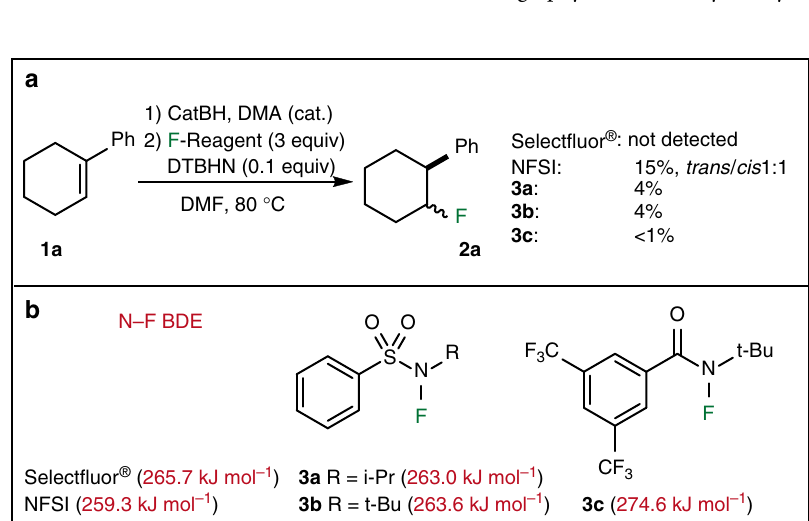
Fig. 2 Initial attempts of hydro fl uorination via formation of B -alkylcatecholboranes. a Hydro fl uorination of 1-phenyl-1-cyclohexene ( 1a ) with Select fl uor ® , NFSI, and N - fl uoro- N -alkylamides 3a – 3c . b Solution phase (DMF) N – F bond BDEs ( Δ H sol ) calculated at the G3(MP2)-RAD level of